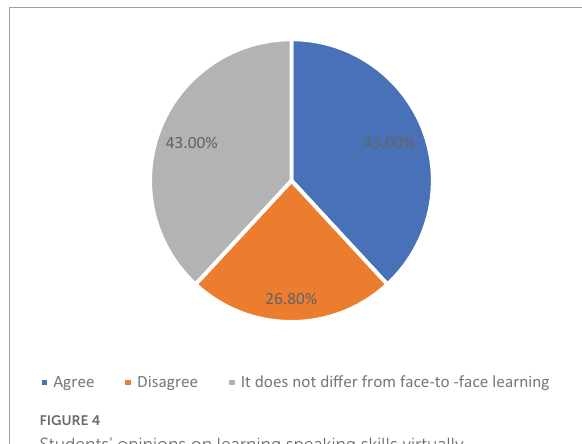
FIGURE3 Students’ opinions on acquiring listening skills virtually.